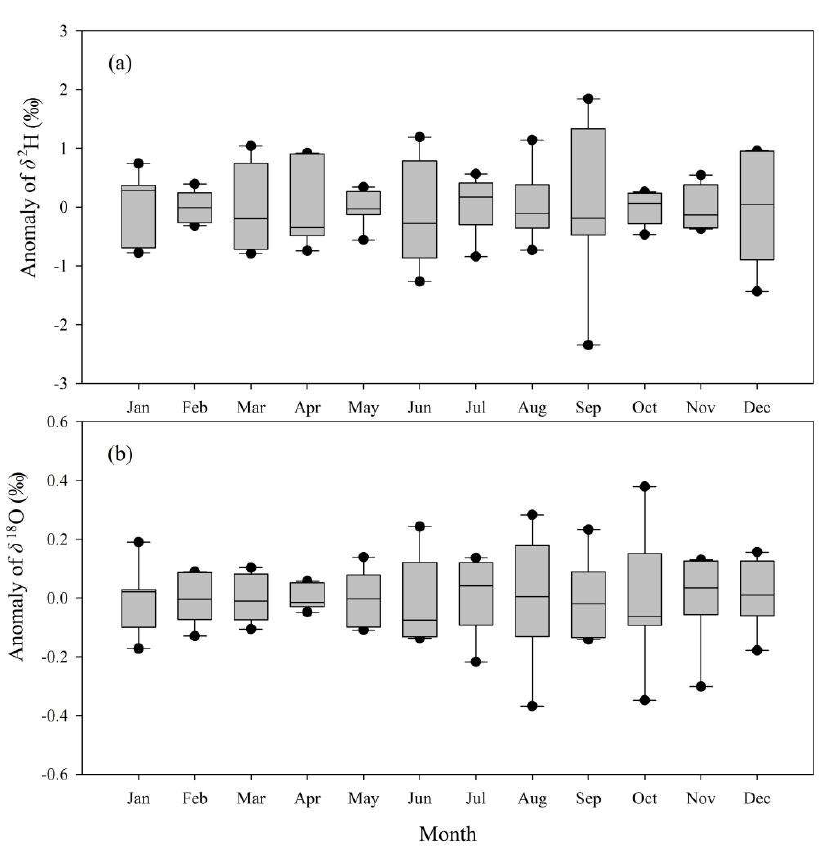
Figure 7. Monthly anomaly values of stable isotope ratios in tap water in Lanzhou. ( a ) monthly anomaly of δ 2 H, ( b ) monthly anomaly of δ 18 O. The anomaly value of one sampling site means the difference between the monthly value at this sampling site and the mean value at all sampling sites in the same month. The bottom and top of the box indicate the 25th and 75th percentiles, the line in the box marks the 50th percentile (median), whiskers exhibit the 10th and 90th percentiles; points below and above the whiskers show the 5th and 95th percentiles, respectively.